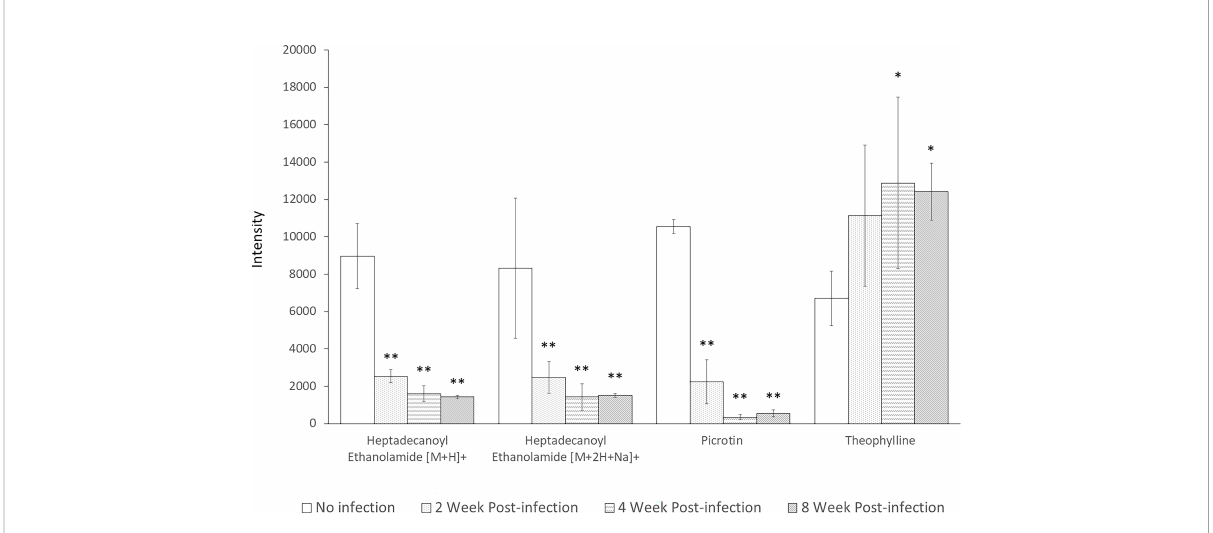
FIGURE 6 Levels of Heptadecanoyl Ethanolamide with [M+H]+ adduct, Heptadecanoyl Ethanolamide with [M+2H+Na]+ adduct, Picrotin, and Theophylline at all time-points. * indicates statistical signi fi cance with p -value < 0.05. ** indicates statistical signi fi cance with p -value <